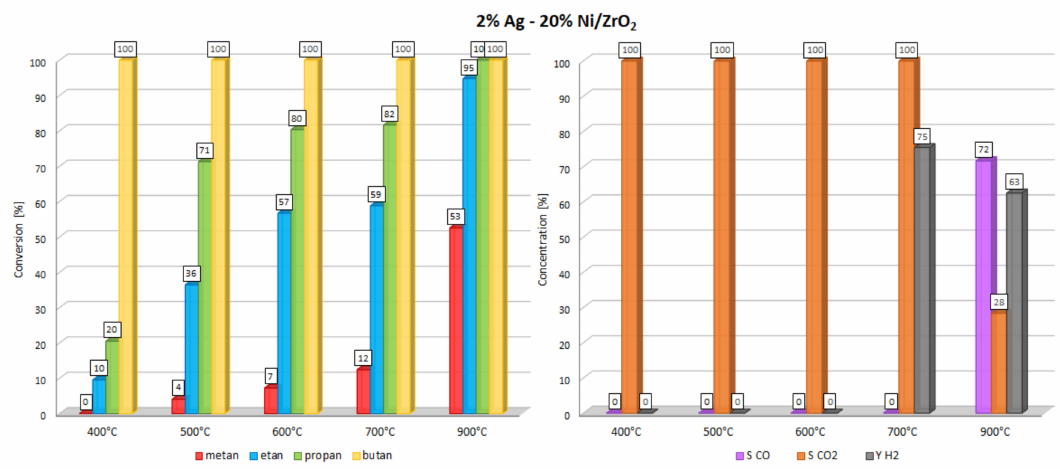
Figure 5. The activity results of the 1% Ag-20% Ni / ZrO 2 catalyst in OSR-LNG process.